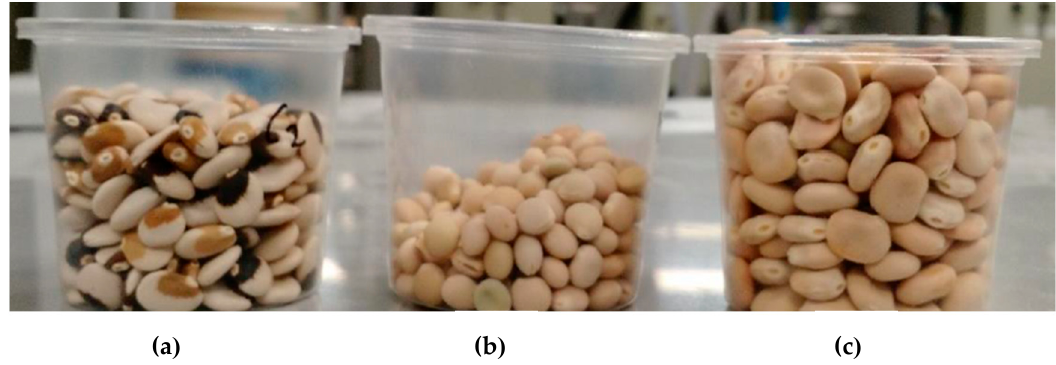
Figure 1. Lupin seeds from different varieties: ( a ) Lupinus mutabilis ; ( b ) Lupinus angustifolius ; ( c ) Lupinus albus .